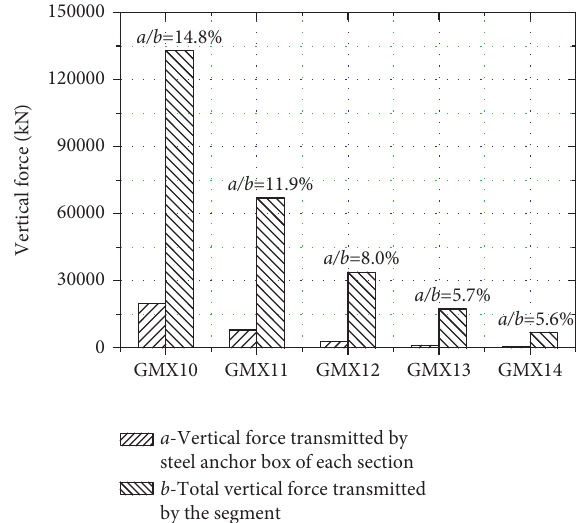
Figure 10: Vertical force transferred by the steel anchor box.